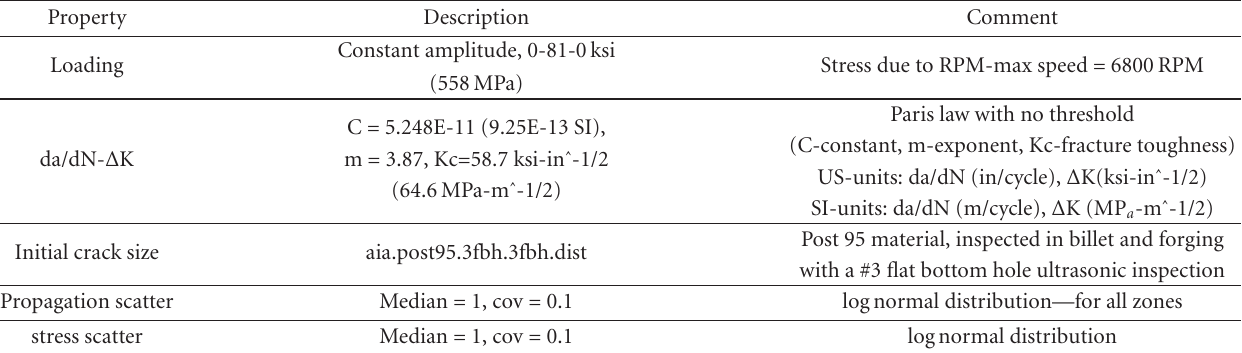
Table 1: Example problem input data.